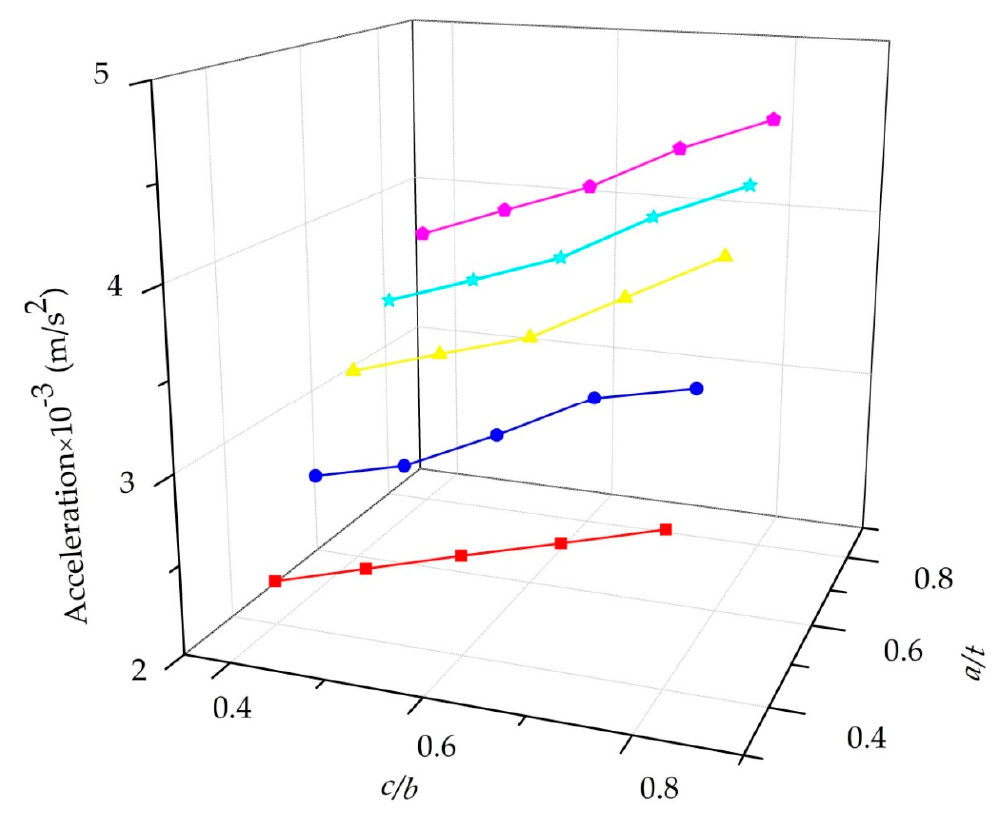
Figure 15. Amplitude curves of bearing outer ring fault characteristic frequencies corresponding to cracks at different a / t and c / b